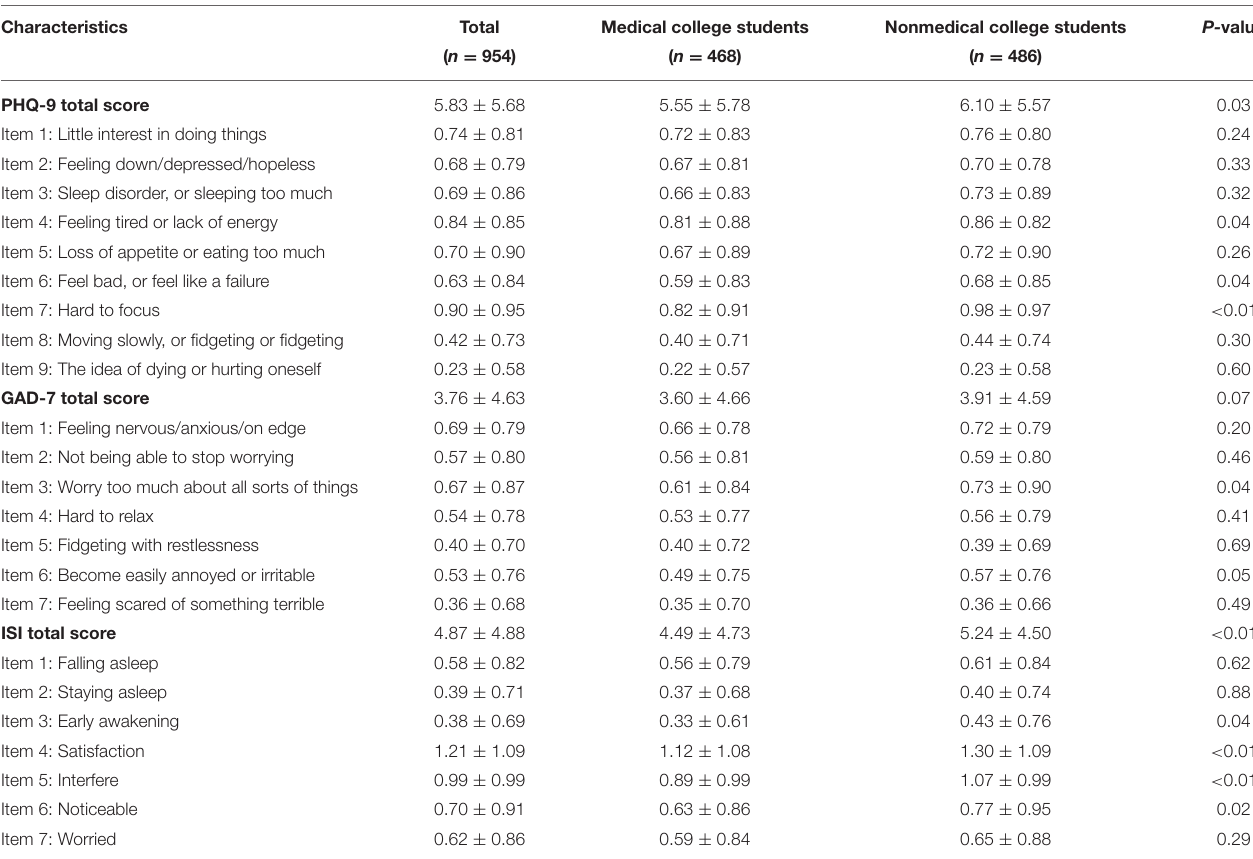
TABLE 3 | Psychological manifestations of medical college students vs. nonmedical college students.